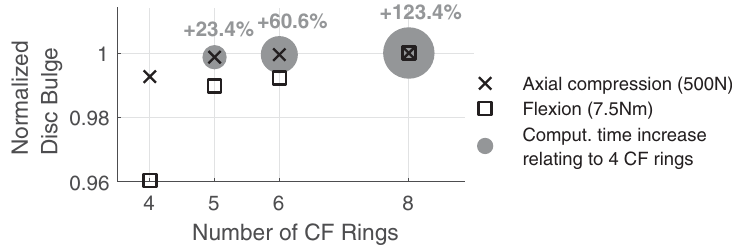
Fig 4. Sensitivity study of normalized disc bulge and computation times with four L4/5 disc models. The disc models vary in their number of CF rings and the associated AGS meshes (Fig 2B). Bulge is measured as the relative displacement of the points of measurement under load compared to the unloaded state. For axial compression disc bulge is averaged from anterior, posterior, and lateral positions. For flexion disc bulge is measured anteriorly only. The computation of one simulation second with four CF rings under increasing load took about 19 seconds on our reference